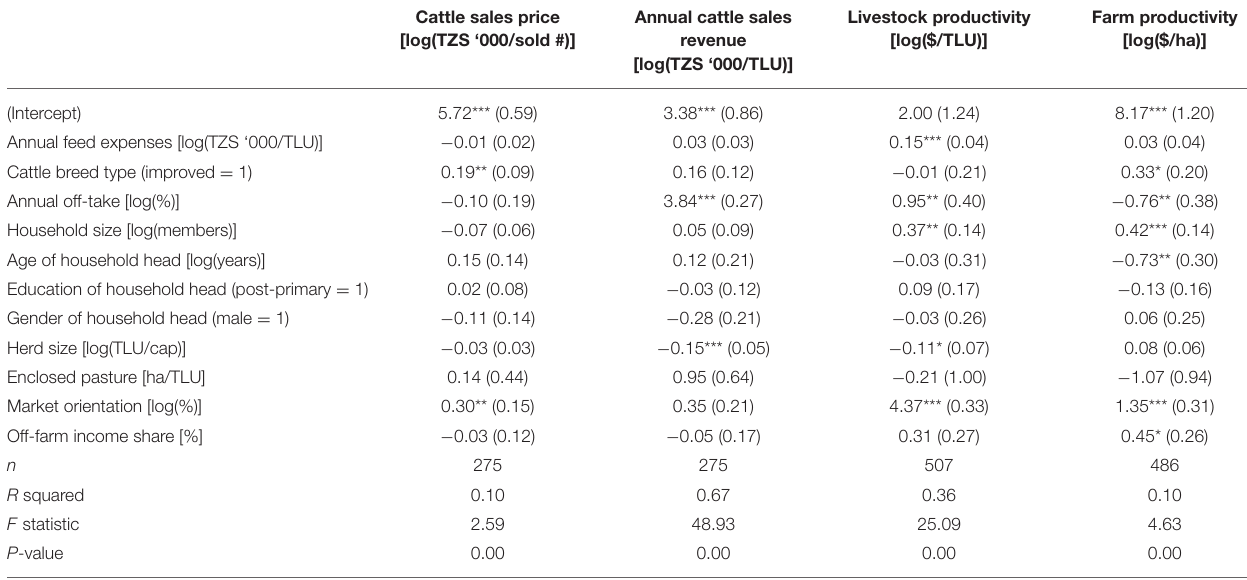
TABLE 9 | Association of farm management with farm success